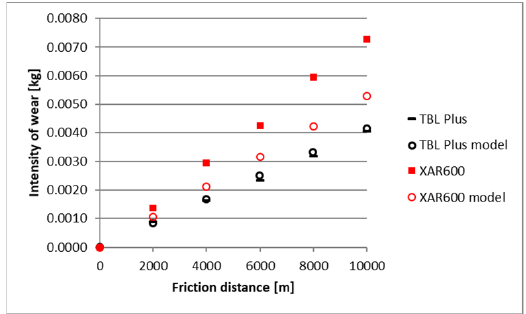
Figure 12. The course of theoretical and empirical wear of XAR 600 and TBL steels in the medium soil.